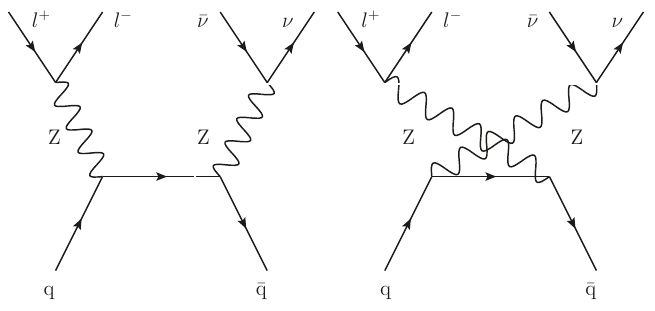
Figure 2 . Representative Feynman diagrams of the SM ZZ